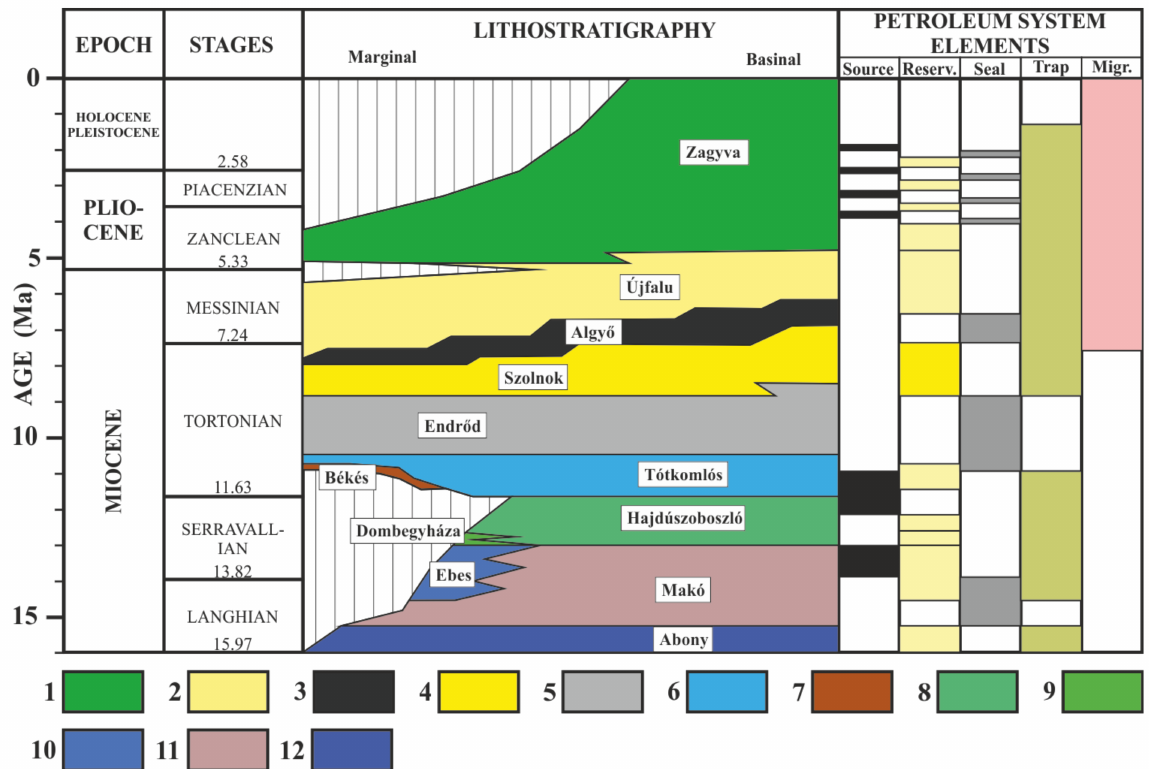
Figure 3. Stratigraphic and petroleum system elements chart of the Great Hungarian Plain (modified after [48,49]): 1 = Alluvial plain; 2 = Lacustrine, self-edge deltas, delta front; 3 = Lacustrine, delta slope; 4 = Lacustrine, deep basin turbidite system; 5 = Lacustrine, deep basin (clay marl); 6 = Lacustrine, shallow to deep basin (calcareous marl); 7 = Lacustrine, rocky shore, shoreface; 8 = Brackish, shoreline, and near shore; 9 = Brackish, shoreline, and abrasional shore; 10 = Marine, shallow marine reef; 11 = Marine, open basin; 12 = Abrasional basal breccia, conglomerate and